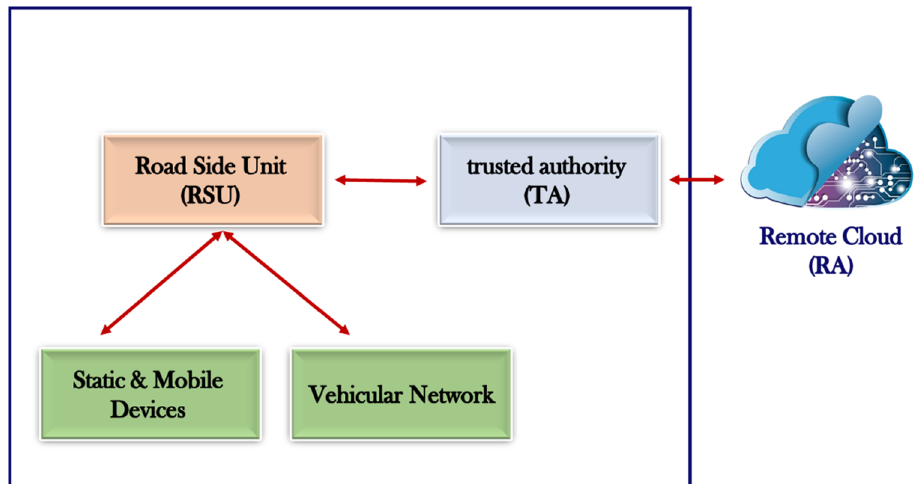
Figure 4. Proposed Network Architecture.